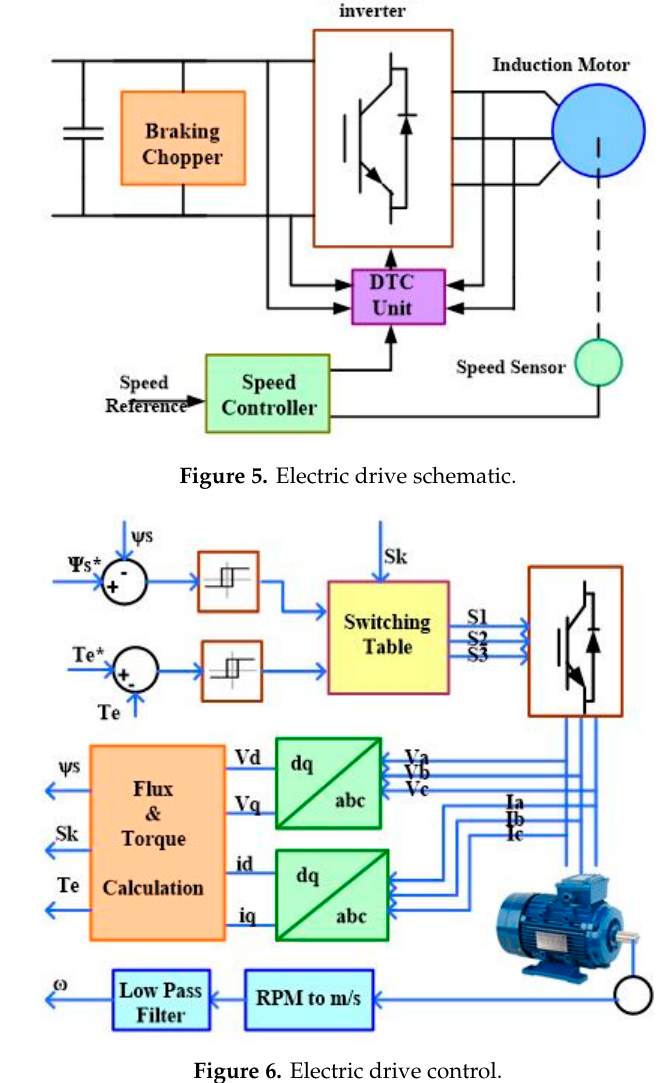
Figure 6. Electric drive control.